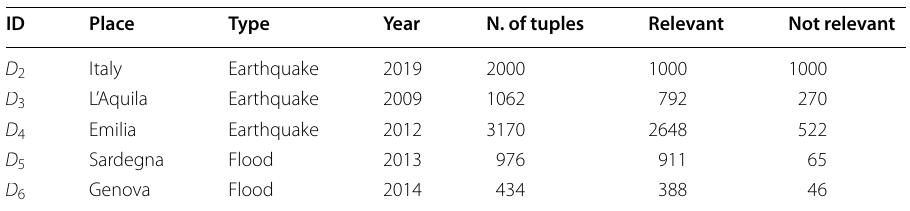
Table 2 Datasets